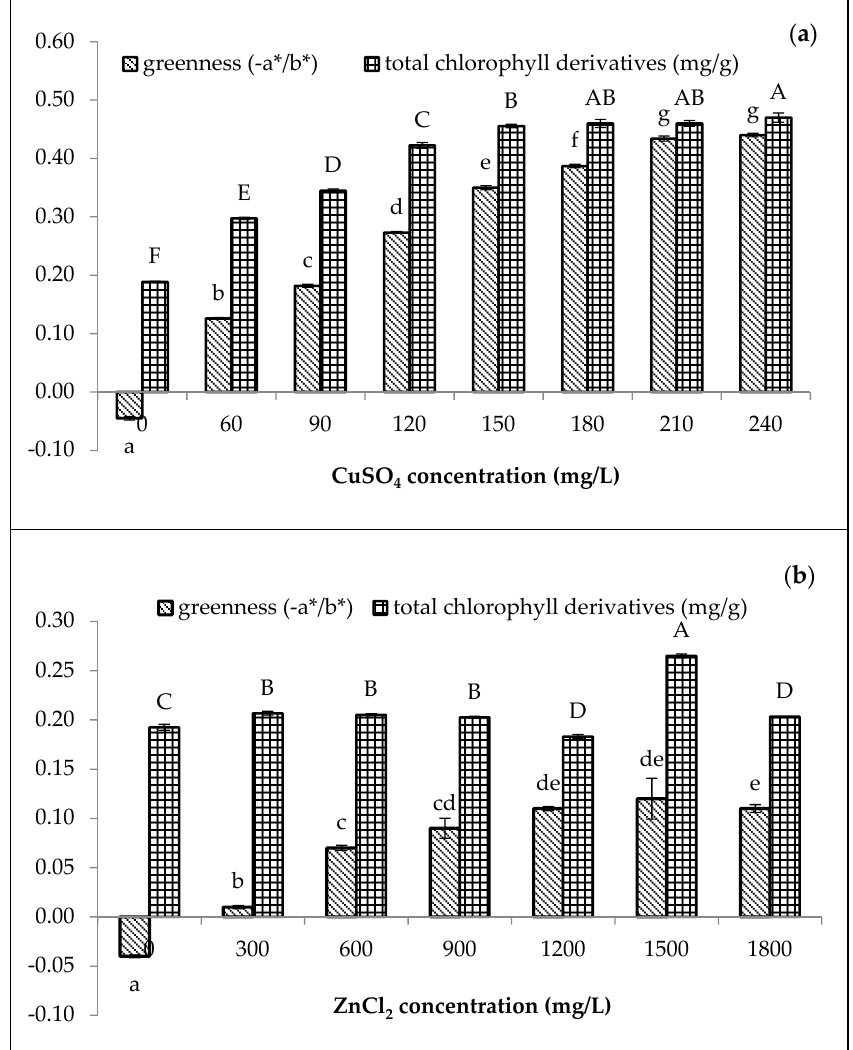
Figure 1 . Effect of metal ( a ) CuSO 4 and ( b ) ZnCl 2 concentrations on greenness ( − a*/b*) and total chlorophyll derivative content (mg/g) of amaranth purees. The study was performed at pH 6 after heating at 80 °C for 15 min. Each value is expressed as mean ± standard deviation ( n = 3) of triplicate analysis. The bars with different lowercase (a–g) and uppercase letters (A–F) indicate significant differences ( p < 0.05) in Tukey’s HSD test.